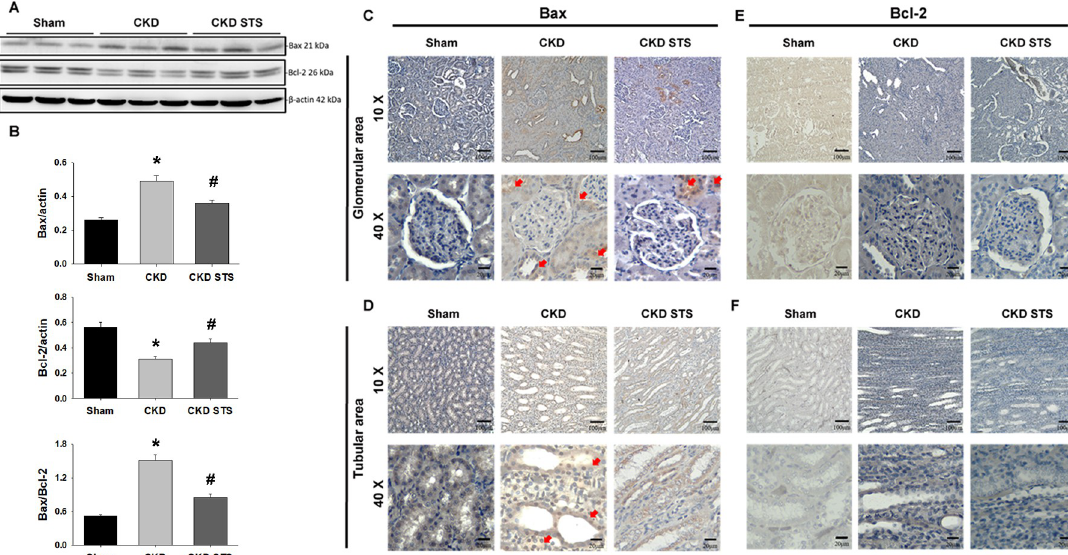
Fig 7. Western blot of Bax and Bcl-2 expression in the kidneys with CKD (A, B). Immunohistochemistry of Bax is primarily enhanced in the tubular area of the CKD and partly in CKD STS kidneys (C, D). Less expression of Bcl-2 in glomerular or tubular areas is denoted (E, F). Data are expressed as mean ± SEM (n = 3). � P < 0.05 vs. Sham. # P < 0.05 vs.